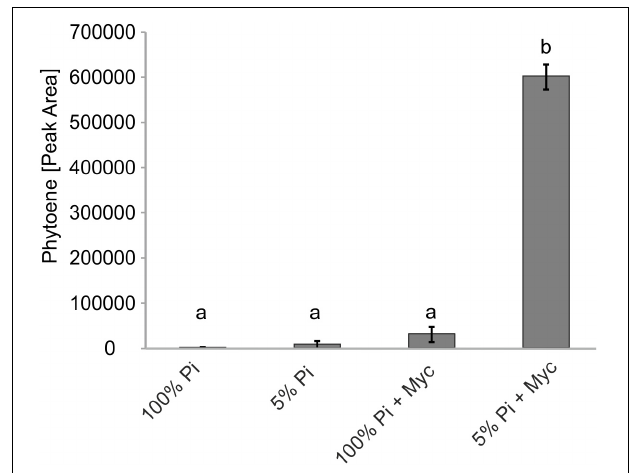
FIGURE 6 | Impact of Pi starvation and mycorrhization on phytoene levels after norflurazon treatments. M. truncatula plants grown under two phosphate supply (100% Pi, 5% Pi) conditions with or without mycorrhization (Myc) as indicated were irrigated with a norflurazon solution for 8 days before harvest after 6 weeks of cultivation. Root extracts were analyzed for relative phytoene content by LC-MS. Error bars derive from SD of three biological replicates. Different lower case letters indicate statistically different values in ANOVA followed by a Tukey HSD test ( p ≤